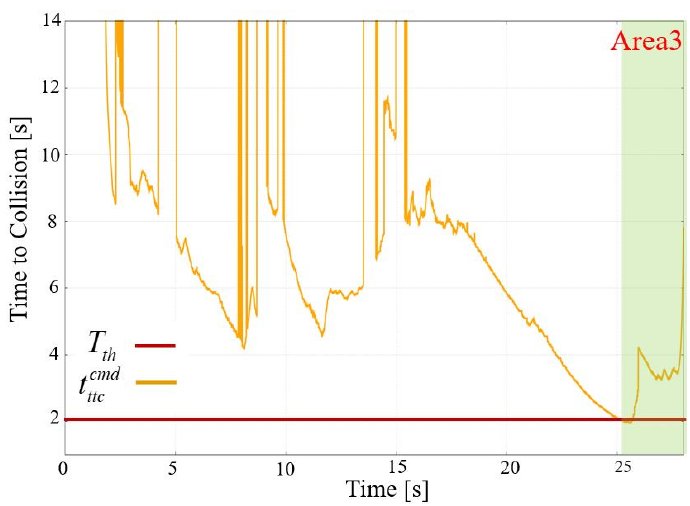
Figure 21. Experimental results of time to collision of Case 4 for Subject